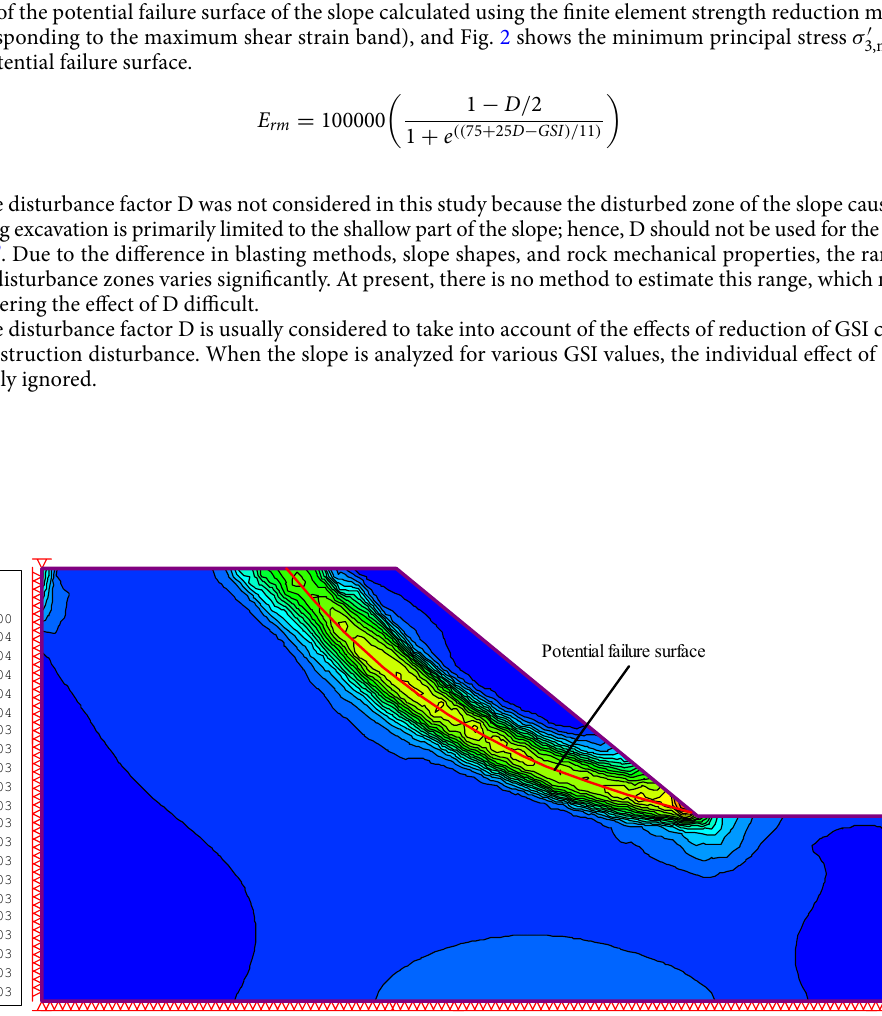
Figure 1. Potential failure surface calculated using the strength reduction method.